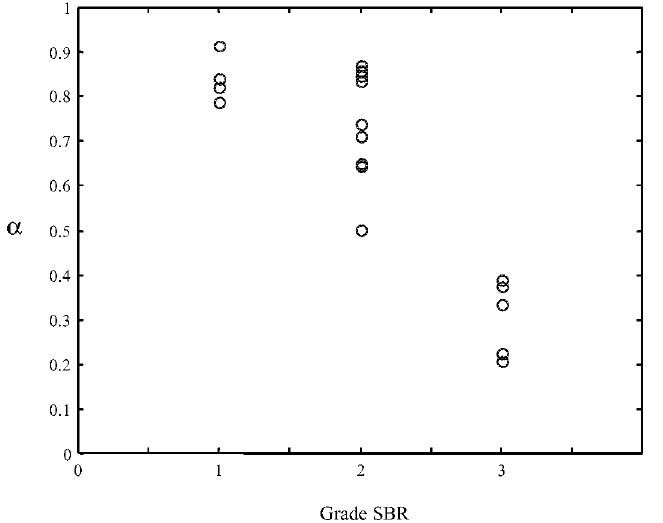
Fig. 4. Asymptotic exponent of dispersion variance ( (cid:11) ) measures heterogeneity and is also a function of SBR grades classified by the pathologist.